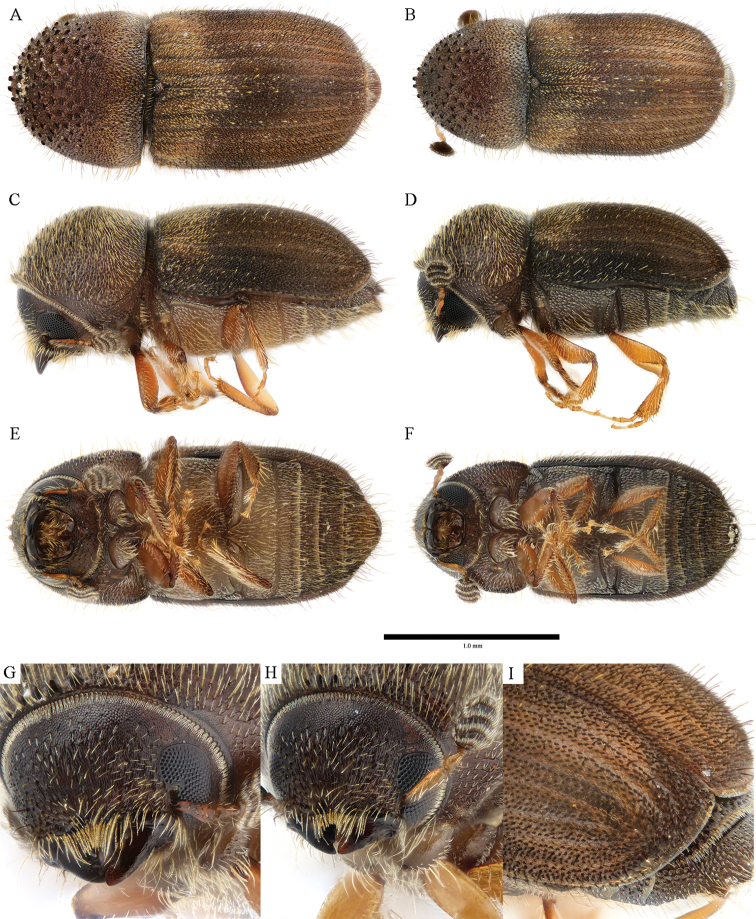
Cryphalus
mangiferaeA, C, E, G female, UFFE:33207 B, D, F, H, I male, UFFE:33208.